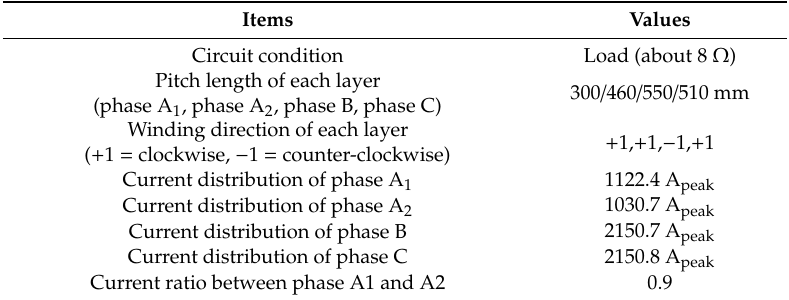
Table 3. Results of current distribution in the tri-axial HTS power cable.